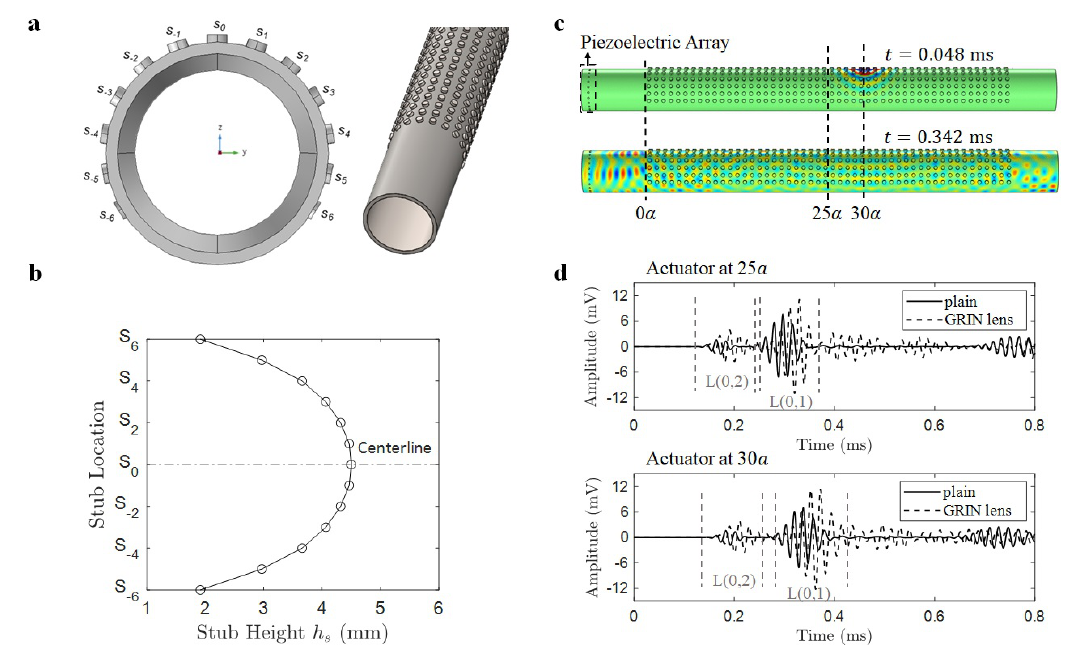
Figure 2. ( a ) Steel pipe with GRIN lens showing distribution of cylindrical steel stubs over pipe surface. ( b ) stub height profile designed using GRIN theory. ( c ) instantaneous radial velocity field showing reciprocal action of the lens (i.e., point source turning into plane wave) for piezo actuator located at 30 a near focal point of L(0,1) mode. ( d ) amplification of wave modes with GRIN lens showing plane wave formation for two actuator positions of 25 a and 30 a